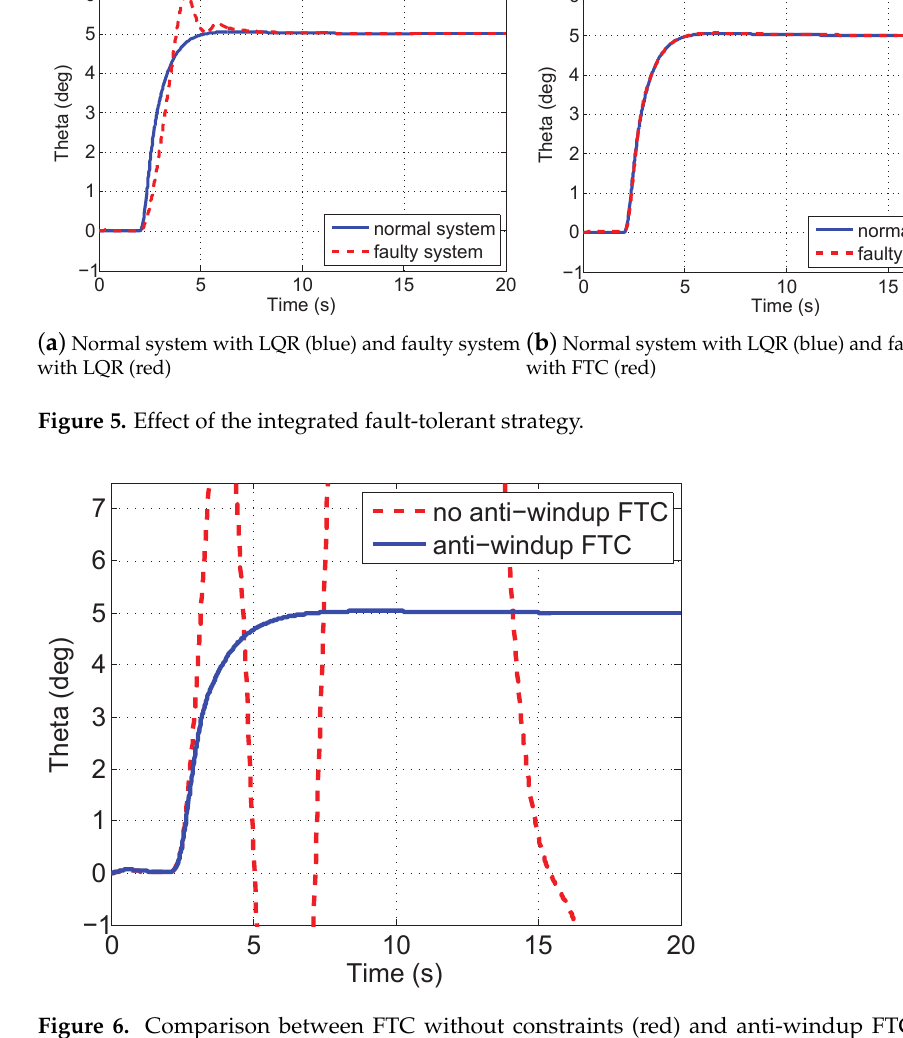
Figure 6. Comparison between FTC without constraints (red) and anti-windup FTC with con- straints (blue).